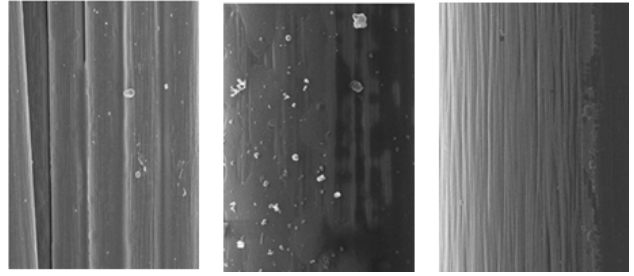
Figure 9. Select the ROI range only saved image.